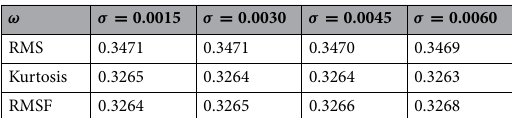
Table 6. Indicator weight under different perturbation